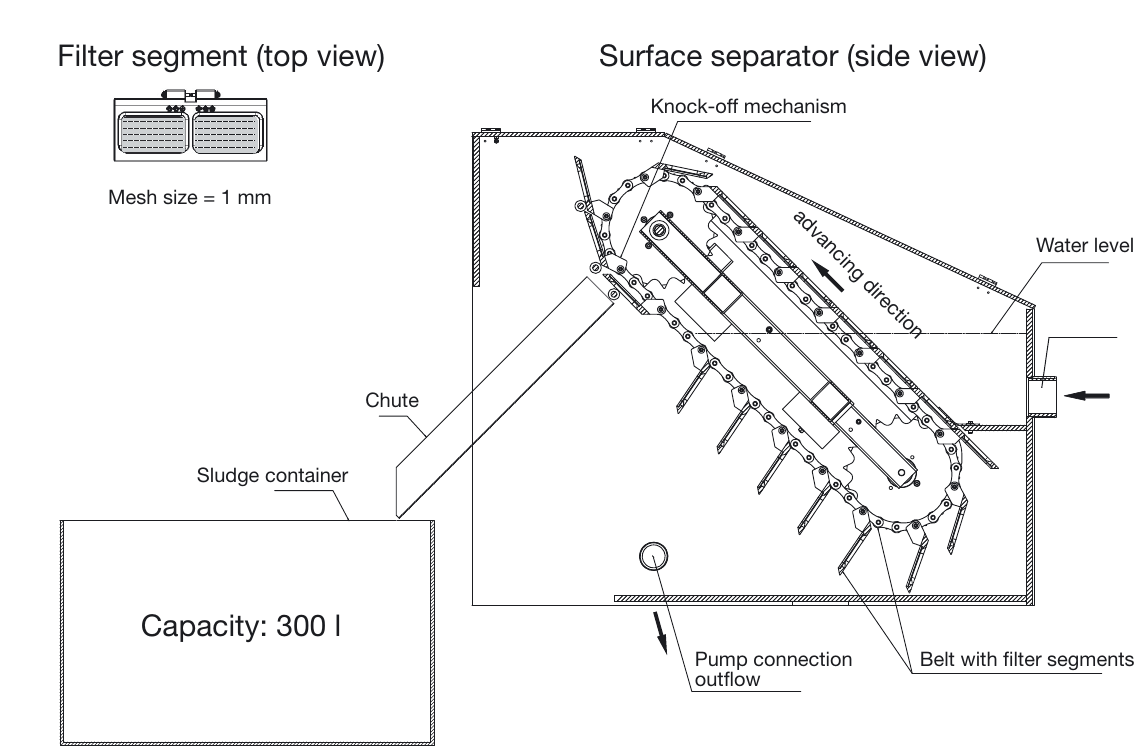
Fig. 2. Schematic of the surface separator. Water inflow/outflow and advancing direction is given by the arrows